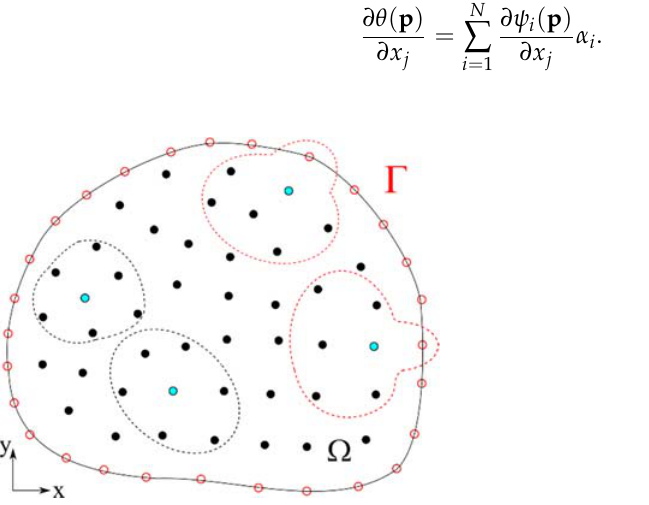
Ω Γ Figure 3. Scheme of the domain and boundary discretization with indicated local influence Figure 3. Scheme of the domain Ω and boundary Γ discretization with indicated local influence domains consisting of 7 node and for each central node in an influence domain is marked in blue. domains consisting of 7 node and for each central node in an influence domain is marked in